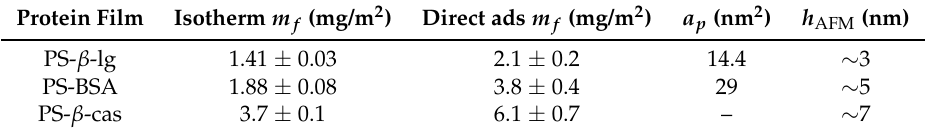
Table 2. Properties of protein films over polystyrene (PS) surfaces obtained at the end of the isotherms or by direct adsorption of protein solutions (1-mg/mL concentration, T = 298 K, pH 6 for BSA and β -lactoglobulin and pH 7 for β -casein). The adsorbed mass m f is obtained by QCM-D, and the thickness h AFM is obtained by AFM in air (see the height profiles in Figure 5). The area per protein is computed from m f of the direct adsorption using Equation